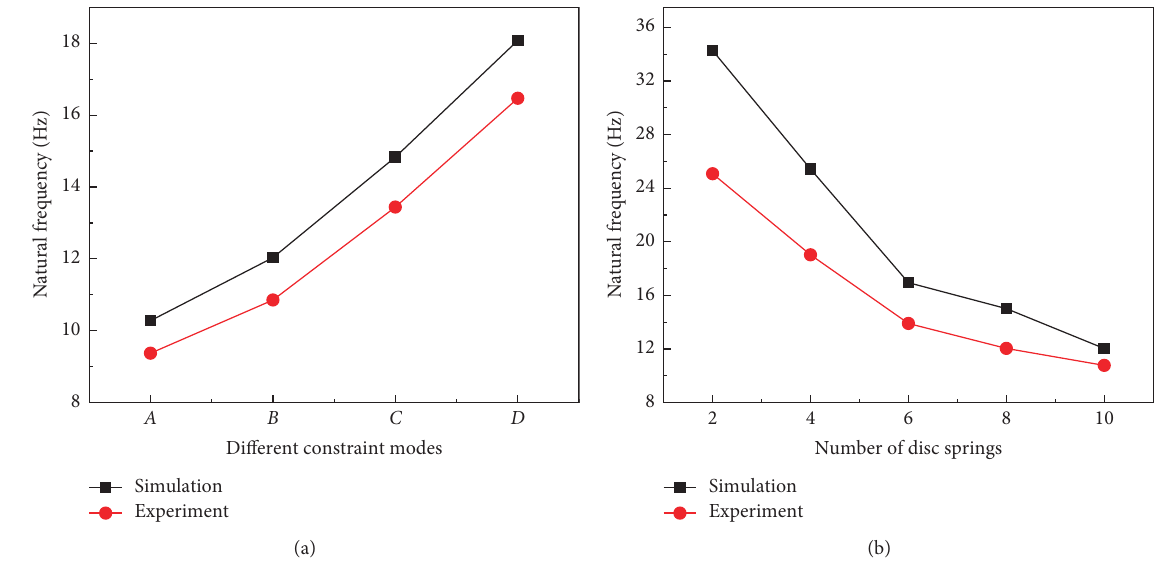
Figure 7: Natural frequency of disc spring system under (a) four different constraint modes and (b) different number of disc springs. A , B , C , and D refer to no locking and no preloading, locking and no preloading, amount of preload compression being less than twice the amplitude, and amount of preload compression being more than twice the amplitude,